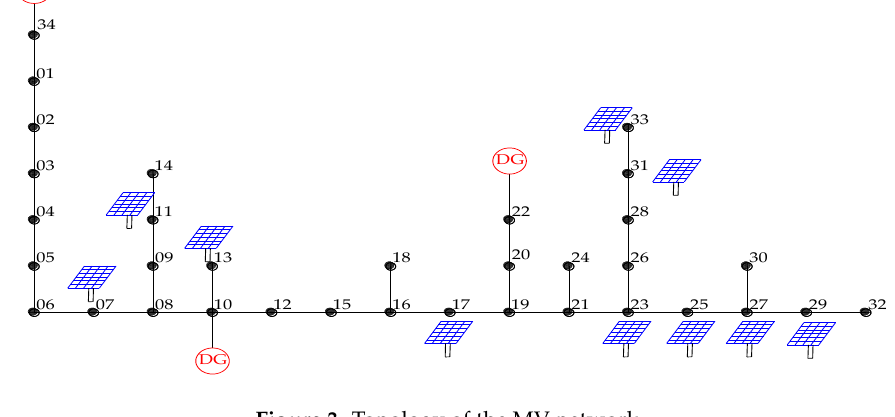
Figure 3. Topology of the MV network.